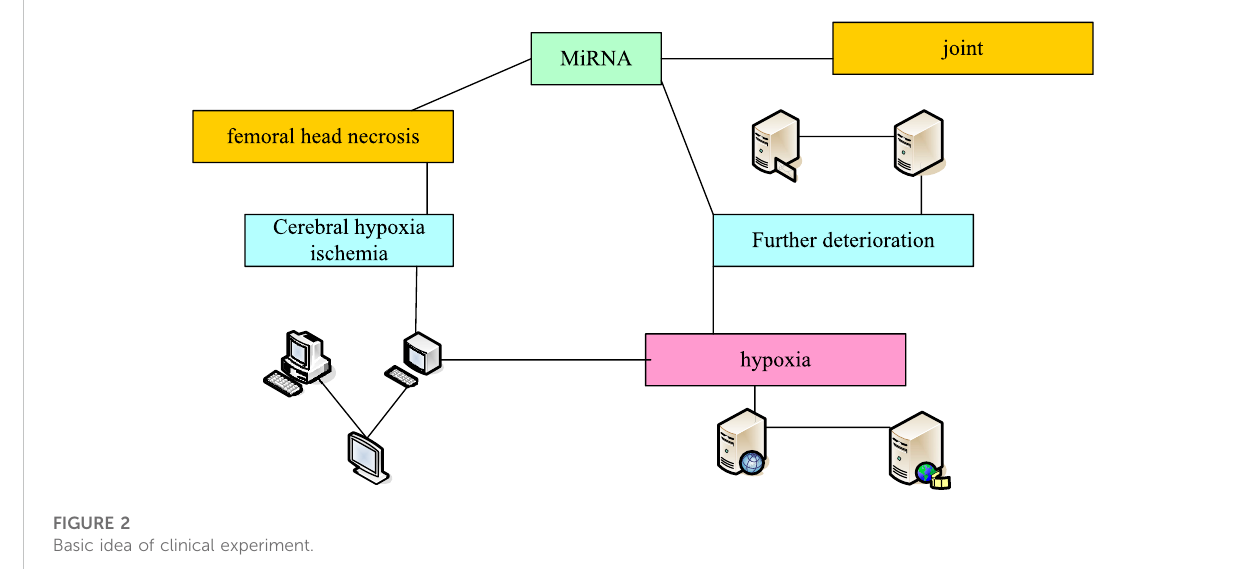
FIGURE 2 Basic idea of clinical